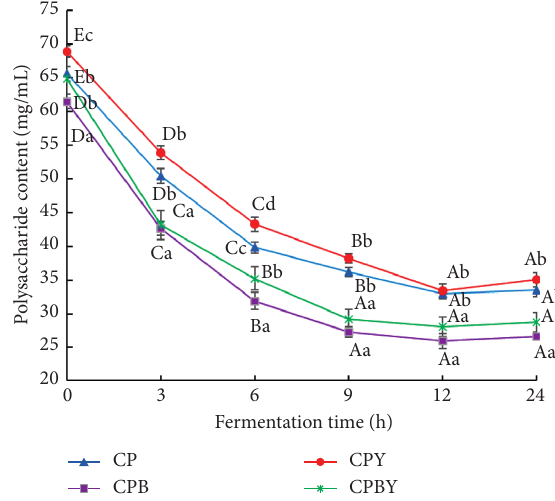
Figure 1: Polysaccharide contents of four samples at different fermentation times. All the values are expressed as mean ± SD ( n � 3). Means with different uppercase letters indicate significant differences of the same sample at the different fermentation time ( p < 0 . 05). Means with different lowercase letters indicate a sig- nificant difference of four group samples at the same fermentation time ( p < 0 . 05). CP: chickpea fermentation milk; CPB: chickpea fermentation milk with enzyme hydrolysis; CPY: chickpea yam fermentation milk; CPBY: chickpea yam fermentation milk with enzyme